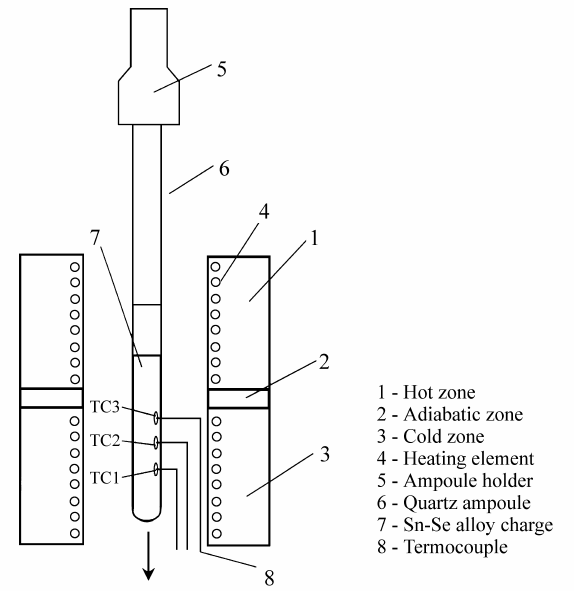
Figure 1. A schematic drawing of the directional solidification apparatus including the provision for the sample temperature measurements.